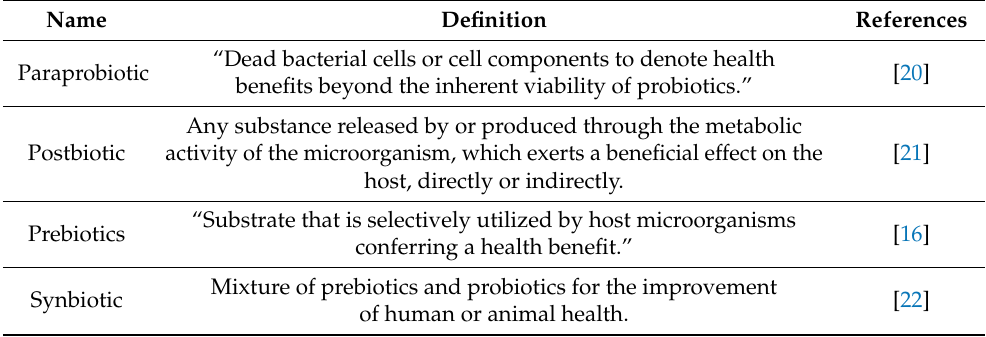
Table 2. Glossary containing the main terminologies associated with probiotics in the specific